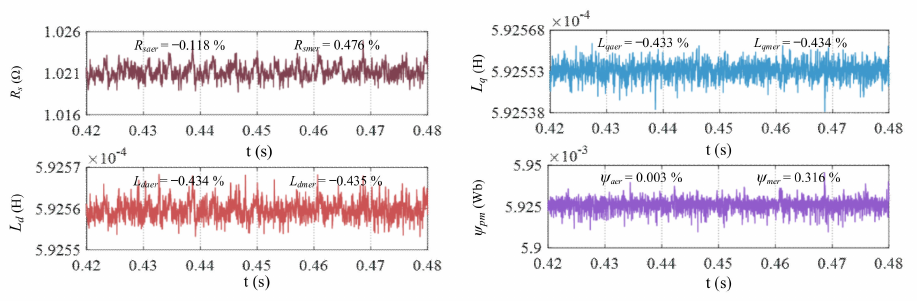
Figure 8. Parameter identification results at 1000 rpm and 0.1 N · m.